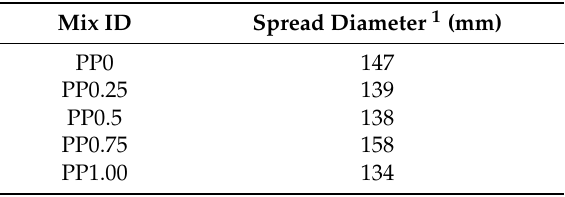
Table 3. The workability results.